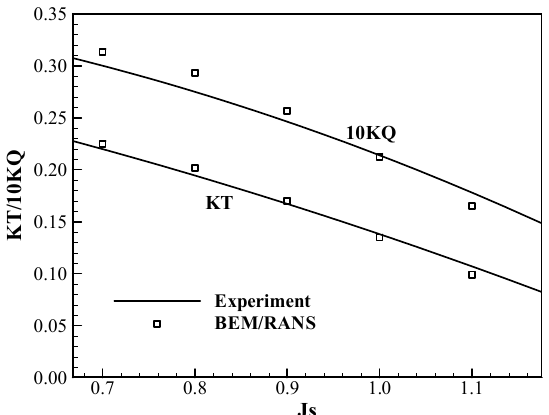
Figure 8. Comparison between the propeller force predicted by the BEM/RANS scheme and that from the experimental data 4 .